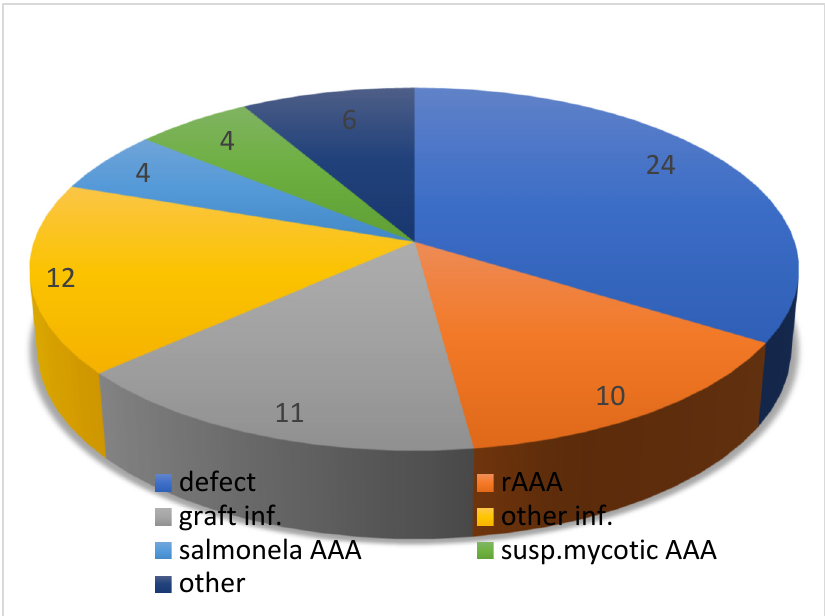
Figure 3. Indications for using silver-impregnated vascular grafts.